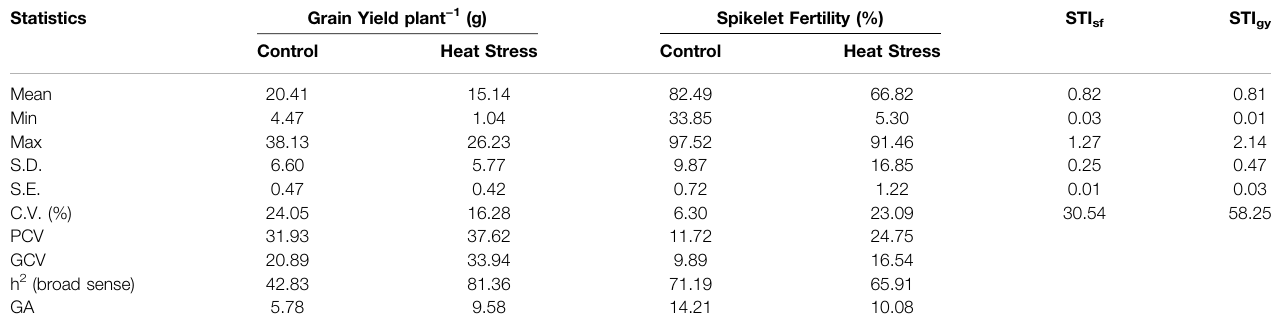
TABLE 1 | Summary statistics of grain yield plant − 1 and spikelet fertility under control and reproductive stage heat stress conditions. Statistics